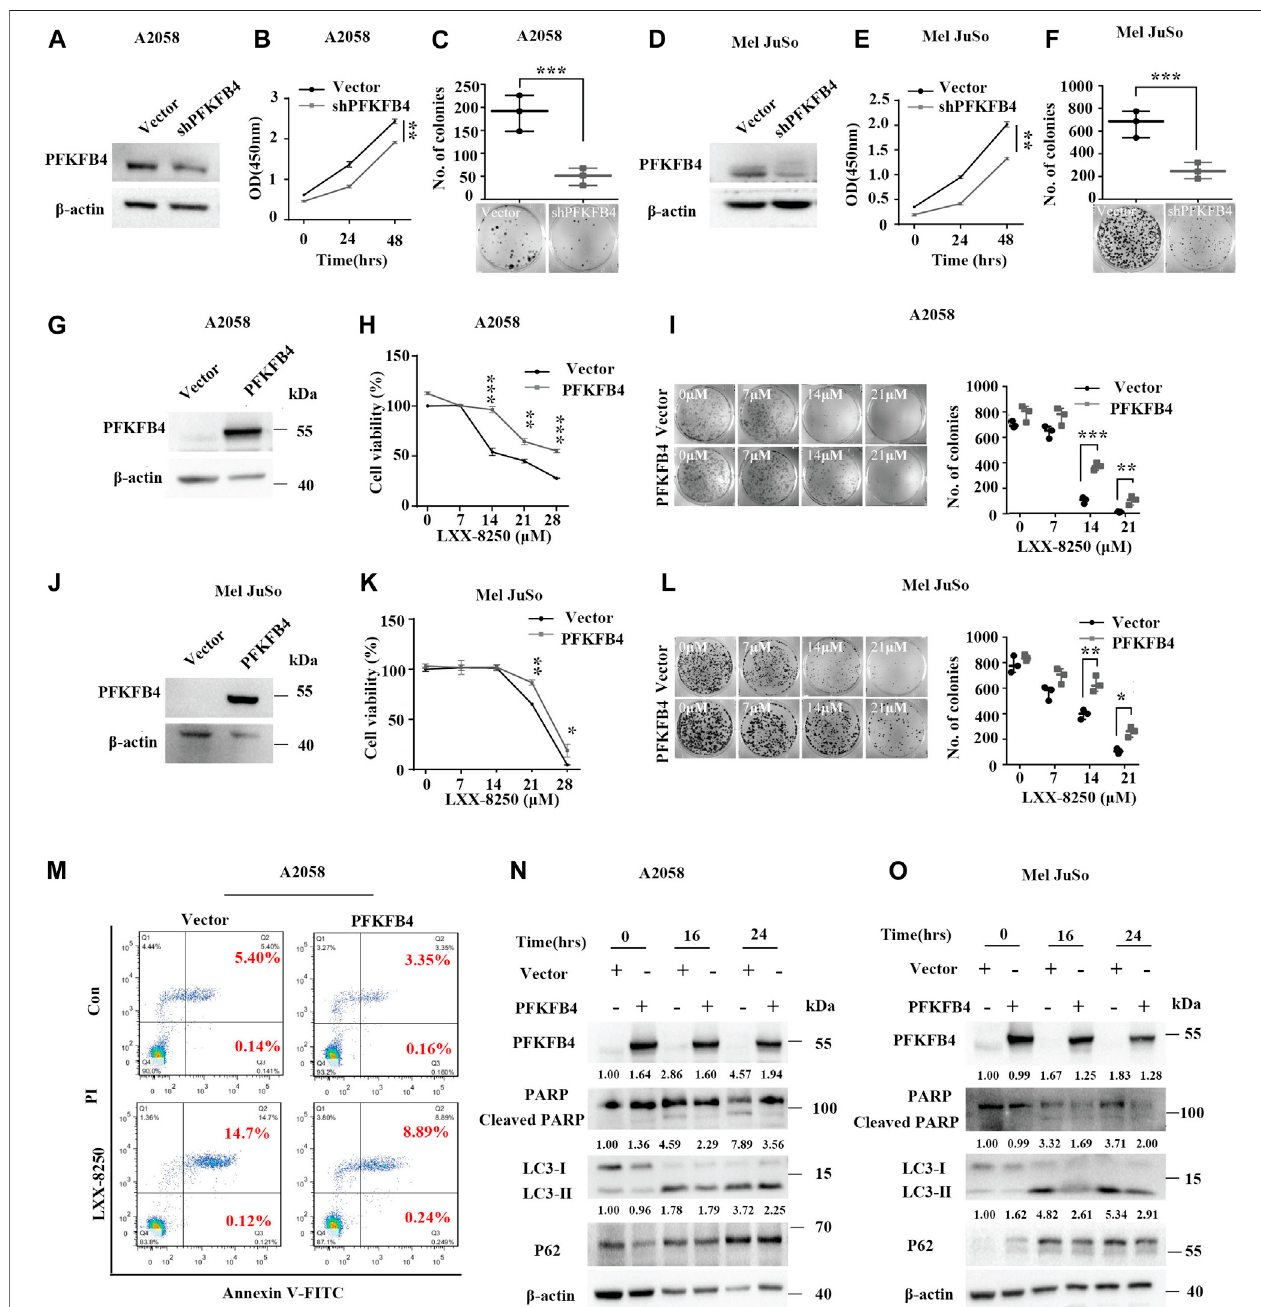
FIGURE4| EffectsofPFKFB4onLXX-8250inducedapoptosis. (A – F) EmptyvectororshRNA(shPFKFB4)wasintroducedintoA2058orMelJuSocells,followed with Western blot analysis (A,D) , cell viability assays (B,E) and colony formation assays (C,F) . (G – L) The A2058 or Mel JuSo cells introduced with empty vector or PFKFB4overexpressionplasmidweretreatedwithLXX-8250attheindicatedconcentrationfor48 h,followedwithWesternblotanalysis (G,J) ,cellviabilityassays (H,K) and colony formation assays (I,L) . (M) The cells introduced with empty vector or PFKFB4 overexpression plasmid were treated with or without LXX-8250 (14.6 μ M), followed by apoptosis assays. (N,O) The cells introduced with empty vector or PFKFB4 overexpression plasmid were treated with LXX-8250 14.6 μ M, (N) ; 22.8 µM, (O) for the indicated time, followed by Western blotting analysis. The quanti fi cation results of the band density (LC3-II, P62 and Cleaved PARP) were labeled above the bands. Data represent mean ± SD. * p < 0.05, ** p < 0.01, *** p < 0.001.